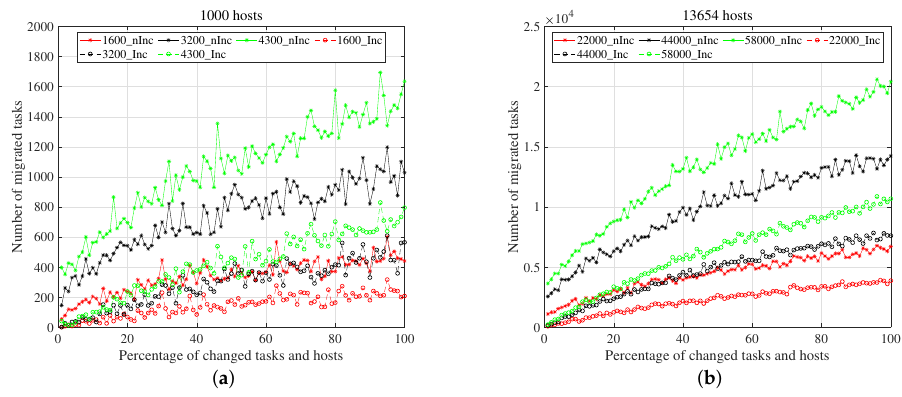
Figure 11. Number of migrated tasks. ( a ) 1000 hosts. ( b ) 13,654